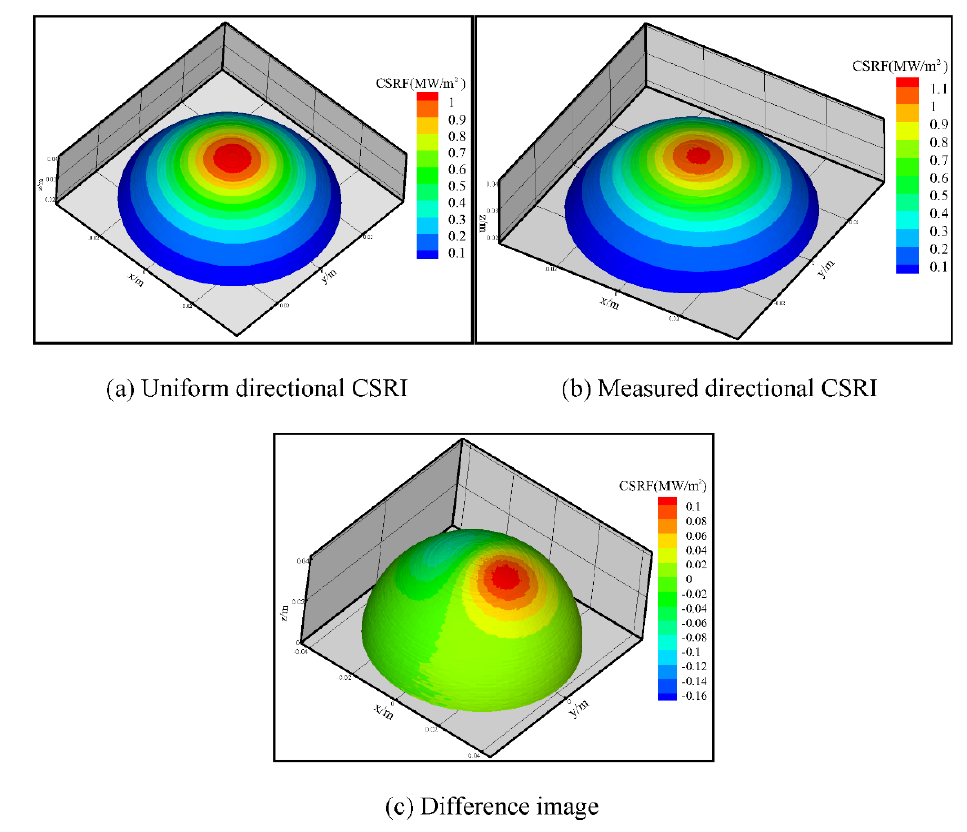
Figure 7. CSRF images on the hemisphere cavity wall with the wall emissivity of 0.85.